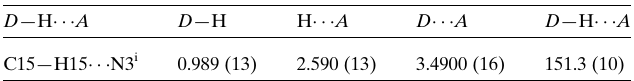
Table 1 Hydrogen-bond geometry (A˚ , (cid:3) ).